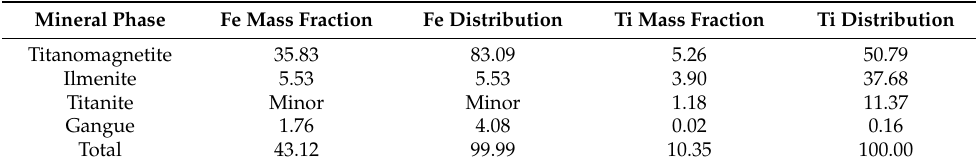
Figure 1. XRD patterns of the LVTC. Table 2. Chemical phase analysis of Fe and Ti in the LVTC/mass